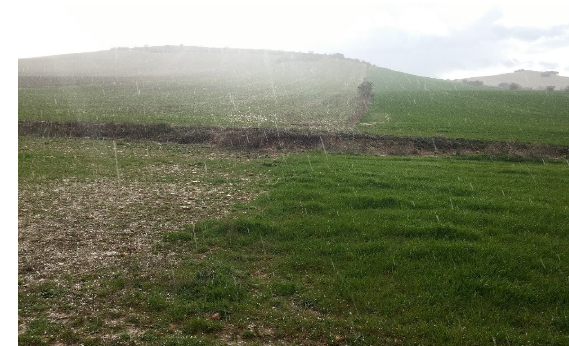
Image 1: Erosion processes. Example of a red zone Image 2: Flooded area. Example of a dark green zone